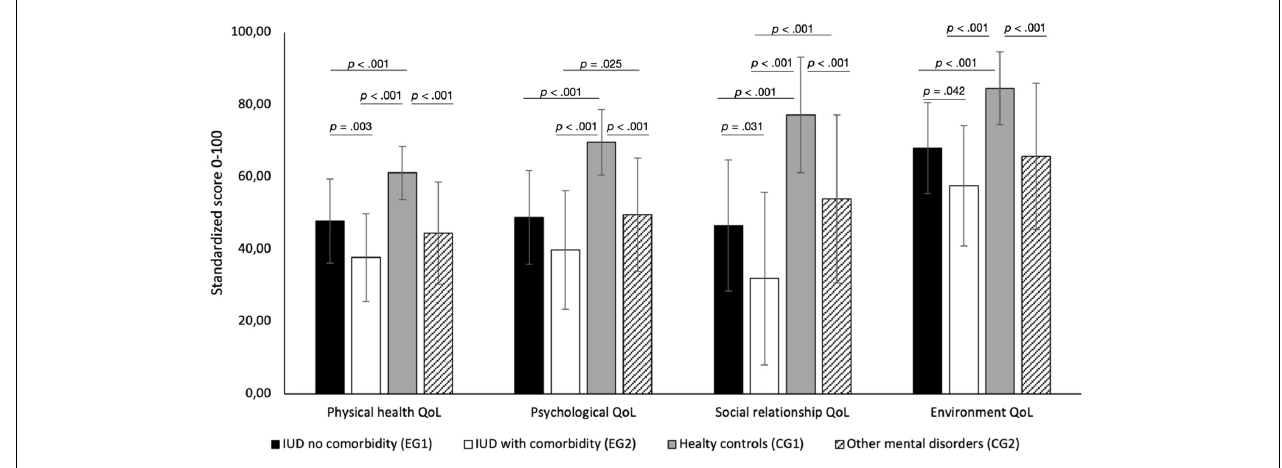
FIGURE 1 | Levels of the 4 quality of life (QoL) dimensions: physical domain, psychological domain, social relations domain, environment domain. Post-hoc tests for the group differences between EG1, EG2, CG1, and CG2 are shown. Only the significant p values are shown.